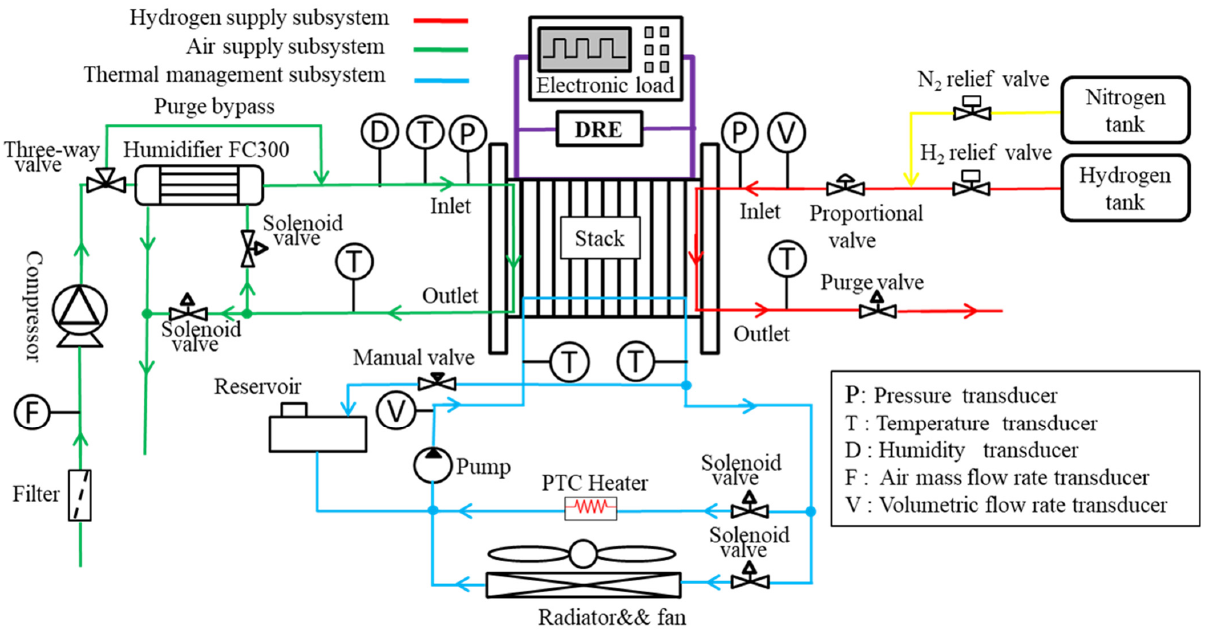
Figure 1. Schematic diagram of PEMFC system test platform.